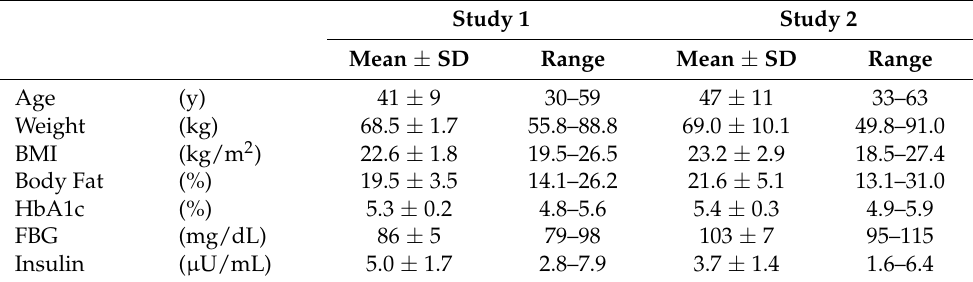
Table 2. Physical characteristics, fasting blood glucose, and insulin at